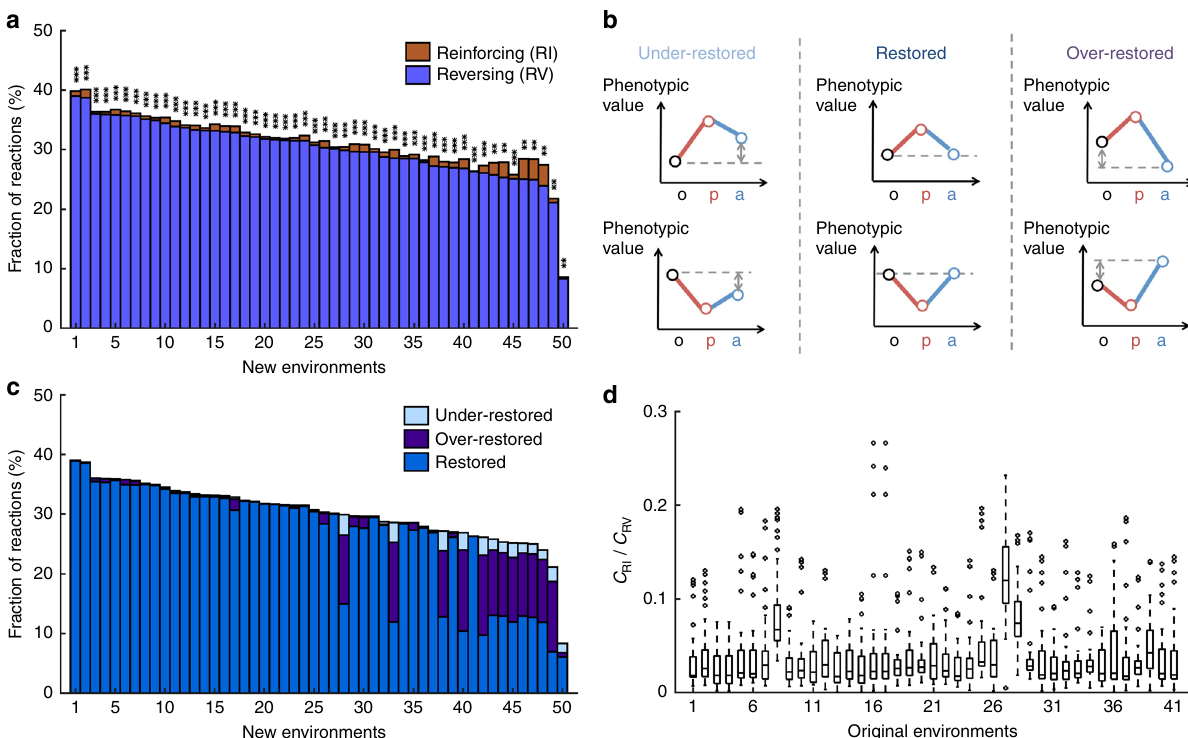
Fig. 2 Predominance of fl ux reversion in the environmental adaptations of E. coli . a Fractions of reactions with reinforcing ( C RI ) and reversing ( C RV ) fl ux changes, respectively, in the adaptation from the glucose environment to each of 50 new environments. Each bar represents the adaptation to a new environment. The equality in the fraction of reinforcing and reversing reactions is tested by a two-tailed binomial test. When C RV > C RI , P -values are indicated as follows: * P < 0.05; ** P < 10 − 10 ; *** P < 10 − 100 ; when C RV < C RI , P -values are indicated as follows: o P < 0.05; oo P < 10 − 10 ; ooo P < 10 − 100 . b Classi fi cation of reversion to three categories based on whether the phenotypic value in the original environment is under-restored, restored, or over- restored. c Fractions of the three categories of reversion in each of the 50 adaptations. d Fraction of reinforcing reactions relative to that of reversing reactions ( C RI / C RV ) in E. coli adaptations to at least 20 new environments from each of 41 original environments examined. The C RI / C RV ratios for all adaptations from each original environment are presented in a box plot, where the lower and upper edges of a box represent the fi rst (qu 1 ) and third (qu 3 ) quartiles, respectively, the horizontal line inside the box indicates the median (md), the whiskers extend to the most extreme values inside inner fences, md ± 1.5(qu 3 − qu 1 ), and the circles represent values outside the inner fences